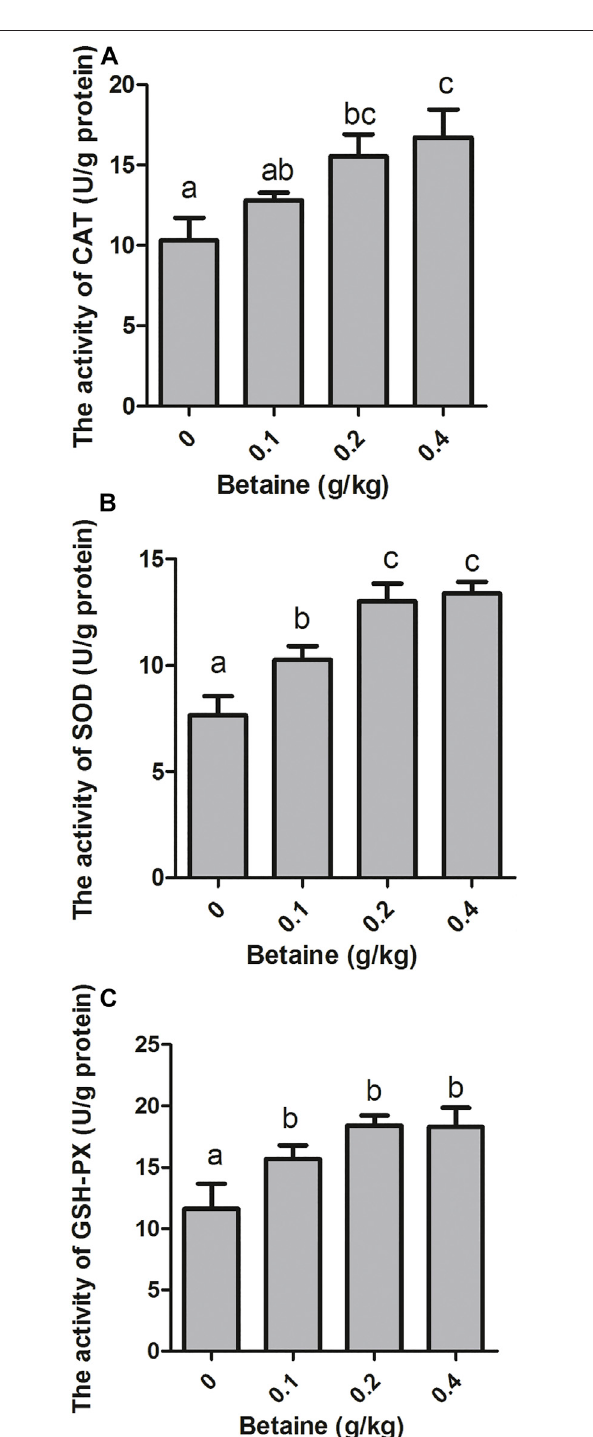
FIGURE 4 | Effect of betaine on the activities of antioxidant enzymes in the liver of zebra fi sh. (A) The activity of CAT; (B) The activity of SOD; (C) The activity of GSH-PX. Values are expressed as means ± sem ( n = 3). Statistically signi fi cant differences are denoted by different letters ( p < 0.05).